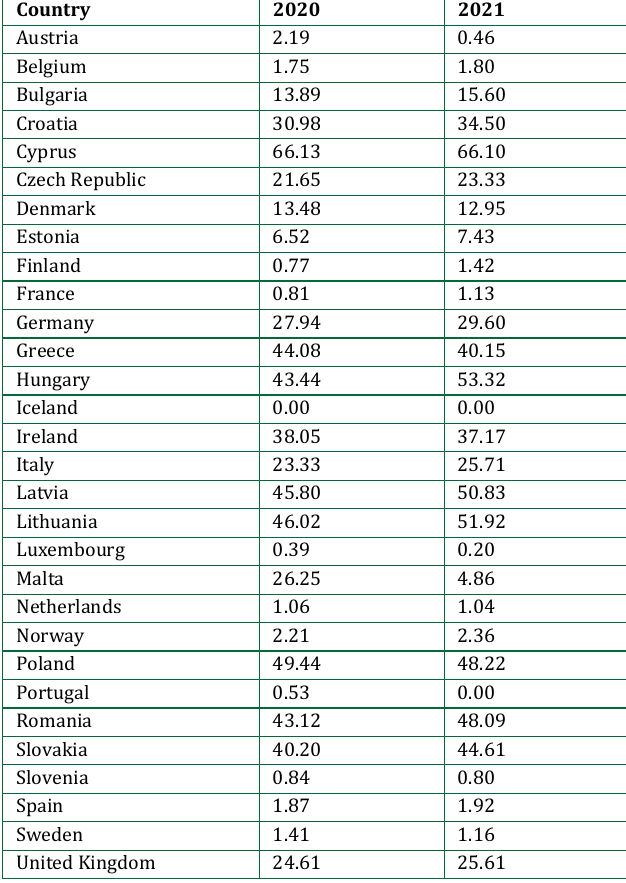
Table 3 recorded the forecasted percentage with resistance to vancomycin for Enterococcus faecium in 2020 and 2021. The prediction of AMR's rates for 17 countries shows an increasing trend, while the others are falling. Table 4: Forecasted AMR’s percentage for Klebsiella pneumoniae